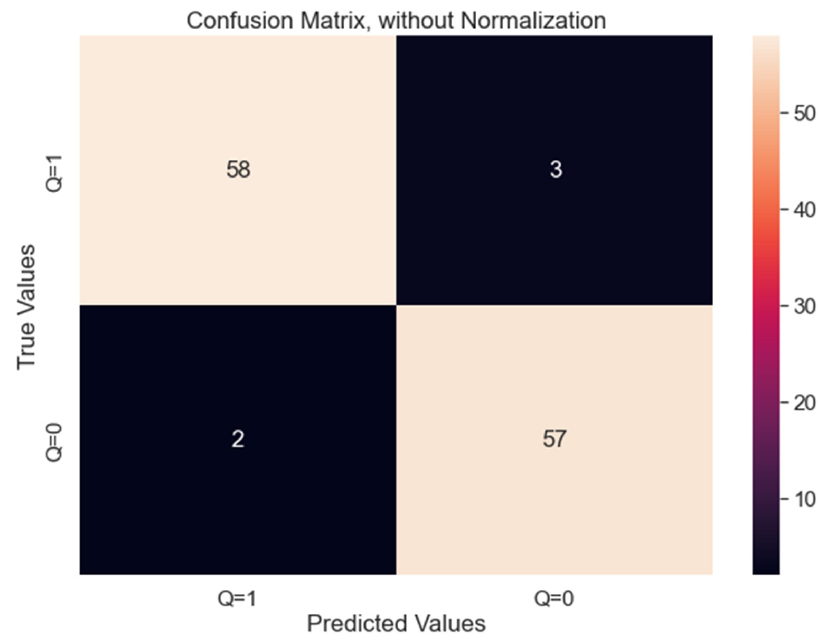
Figure 8. Confusion Matrix.